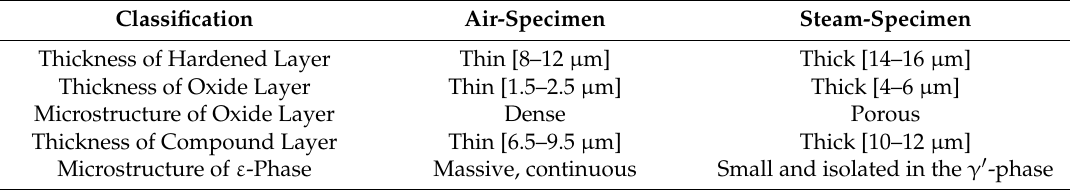
Table 3. Characteristics of the surface hardened layer of each